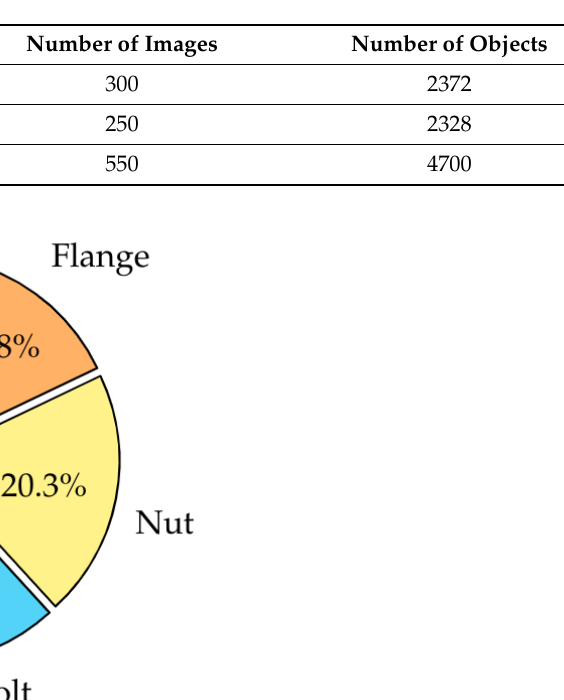
Table 1. Towing Tank Image Datasets.